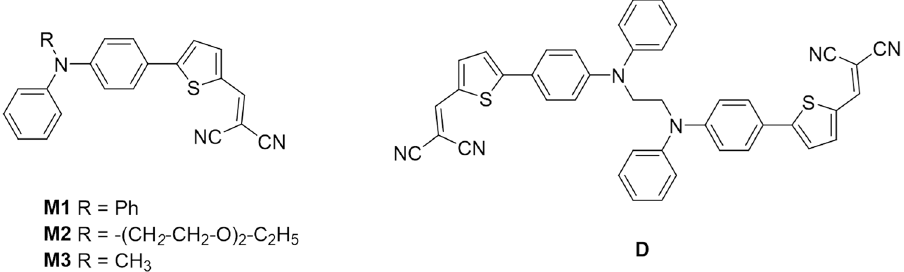
Figure 1. Chemical structure of push-pull monomers and of the target compound D .